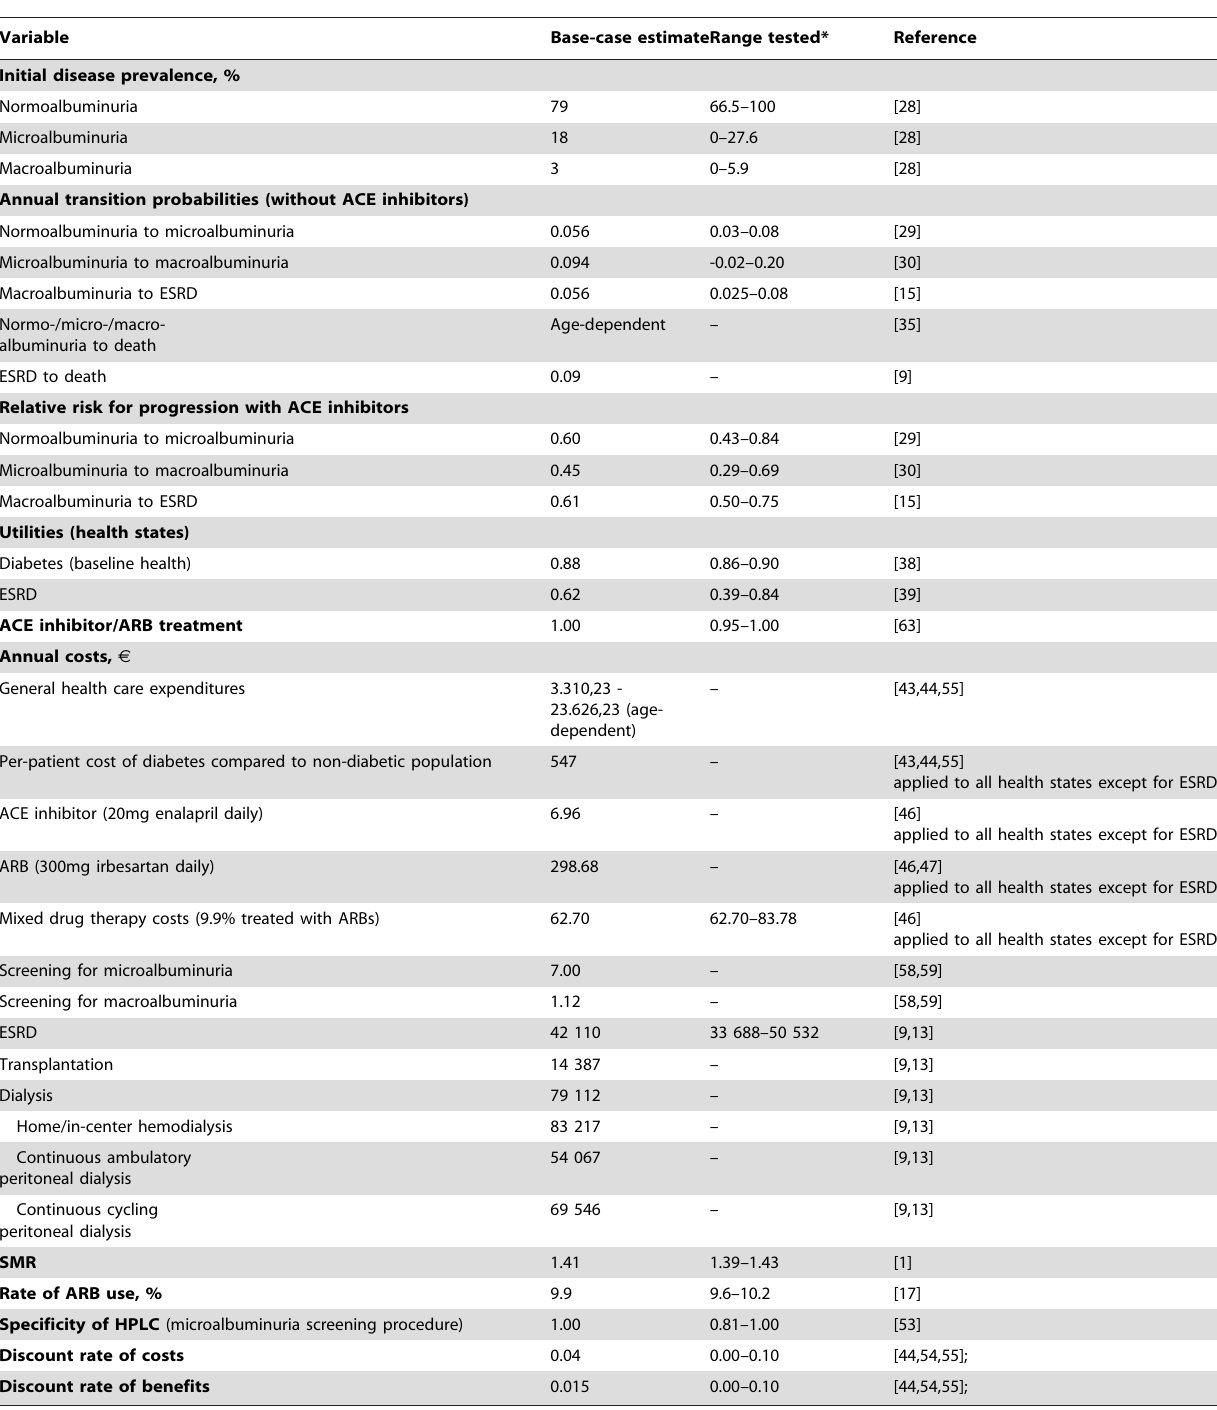
Table 1. Data used to determine the cost-effectiveness of ACE inhibitors and ARBs in newly diagnosed type 2